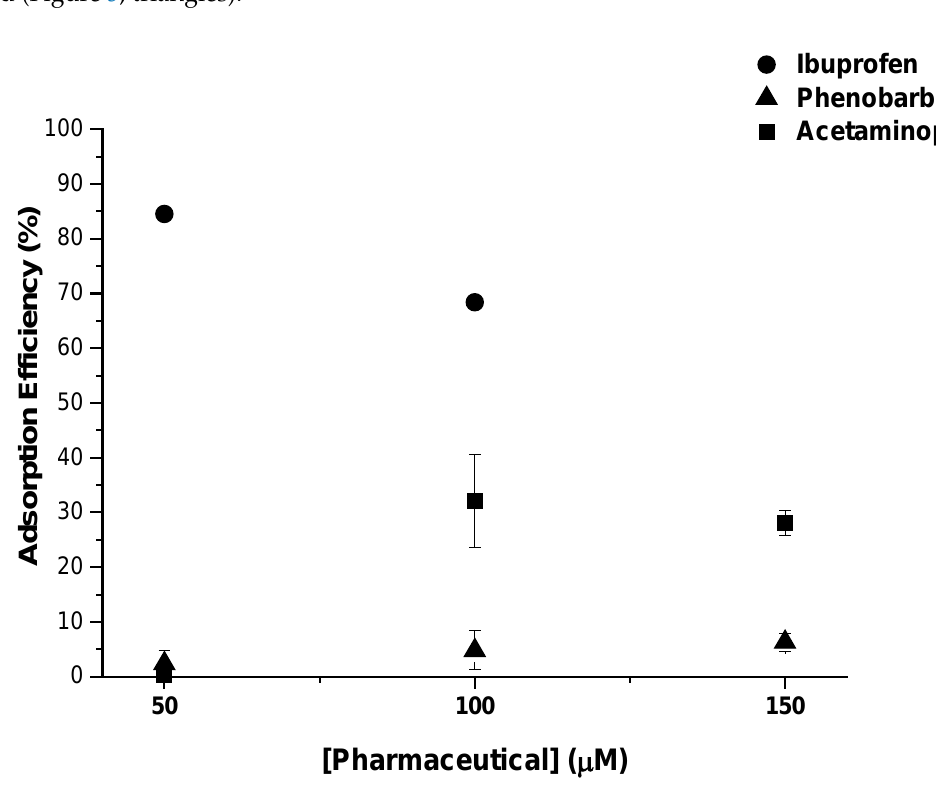
Figure 5. Adsorption e ffi ciency (%) of ibuprofen at concentrations of 50 and 100 µ M, and acetaminophen and phenobarbital at concentrations of 50, 100, and 150 µ M by TpBD-(CF 3 ) 2 ( C 0 = 330 mg L − 1 ) in lake water. The experiment was performed in duplicate.